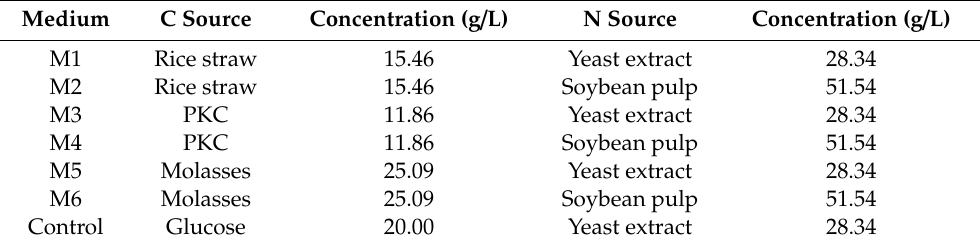
Table 2. Carbon and nitrogen sources supplemented to each formulated medium.